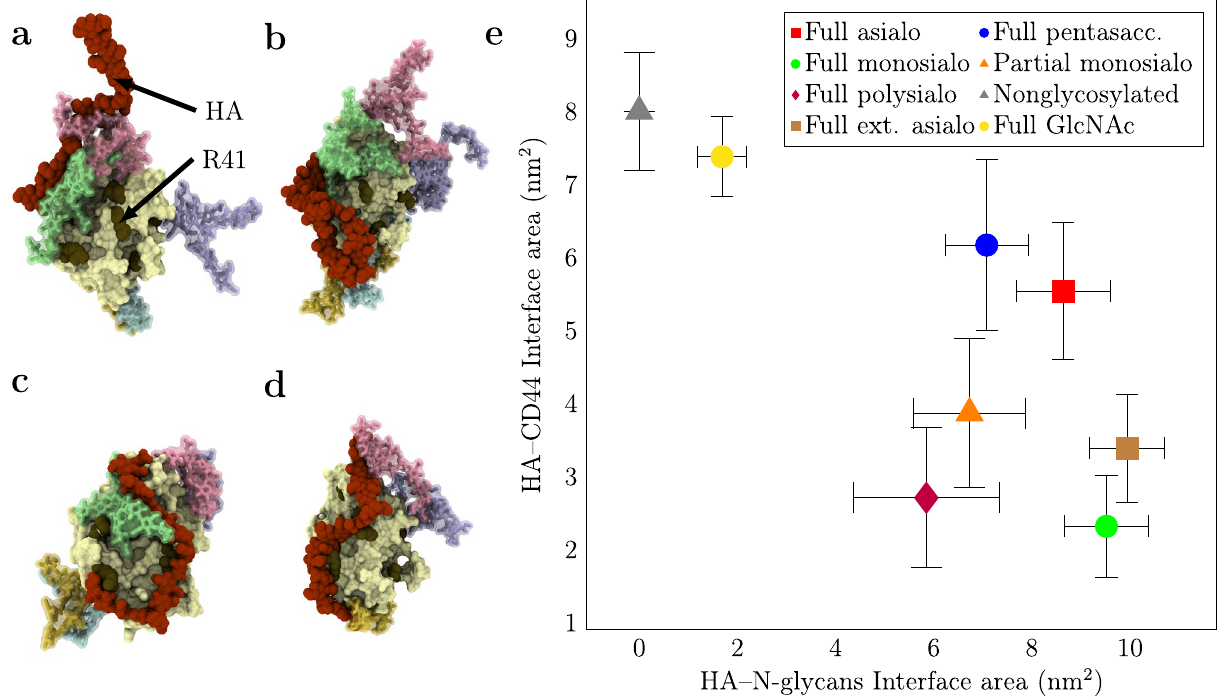
Figure 3. ( a–d ) Example structures ( t = 1000 ns) of HA–CD44 complexes obtained in the spontaneous binding simulations (B3–6 in Table 2). The snapshots shown here are randomly selected from multiple simulation replicas. The color coding for HABD and N-glycans is the same as in Fig. 2. For comparison, examples of nonglycosylated CD44–HA complexes can be found from Ref. 14 . ( a ) full monosialo glycoform (B4),